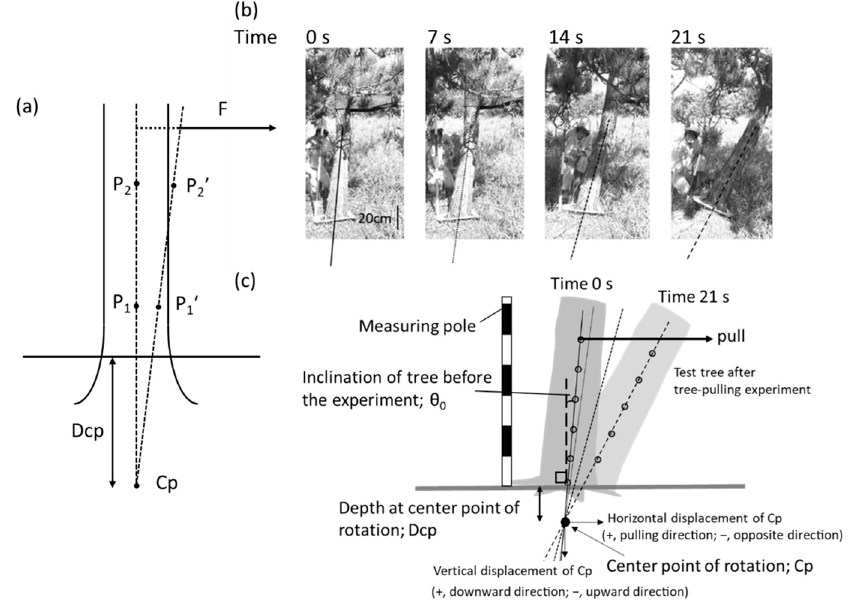
Figure 1. Method of measuring center point of rotation (Cp) and depth at center point of rotation (Dcp) during tree-pulling experiment. ( a ) General scheme (modified from Morioka [36]), ( b ) positions of straight vertical lines on stem surface every 7 s, and ( c ) measurement details.